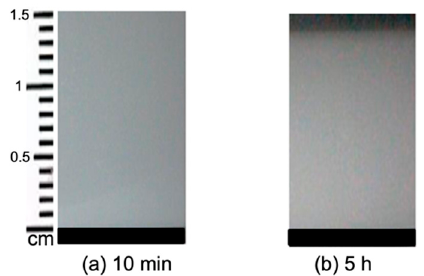
Figure 2. Sample b containing 5% starch in H 2 O at different stages of drying. The evolution time increases from ( a ) 10 min to ( b ) 5 h.